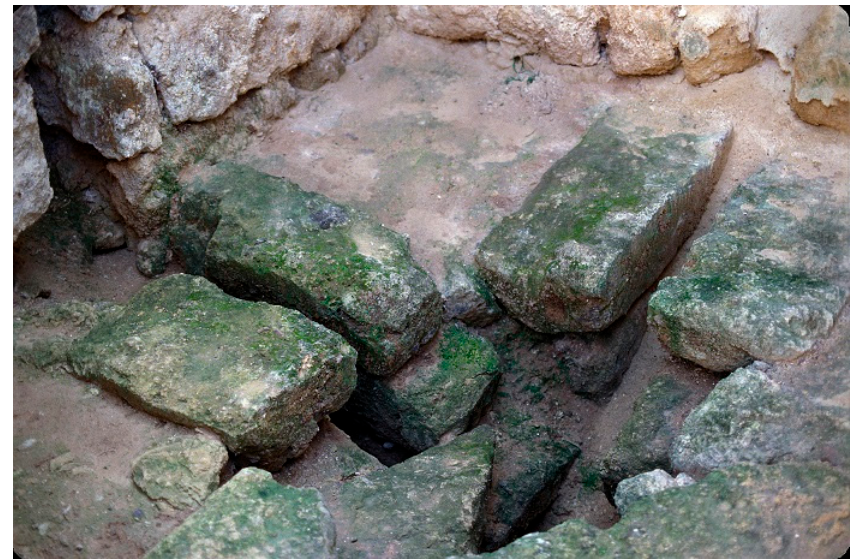
Figure 16. Eastern Service House, No. 12. Double latrine. (Photo M. Pijuán © Conjunto Arqueológico de Madinat al-Zahra).